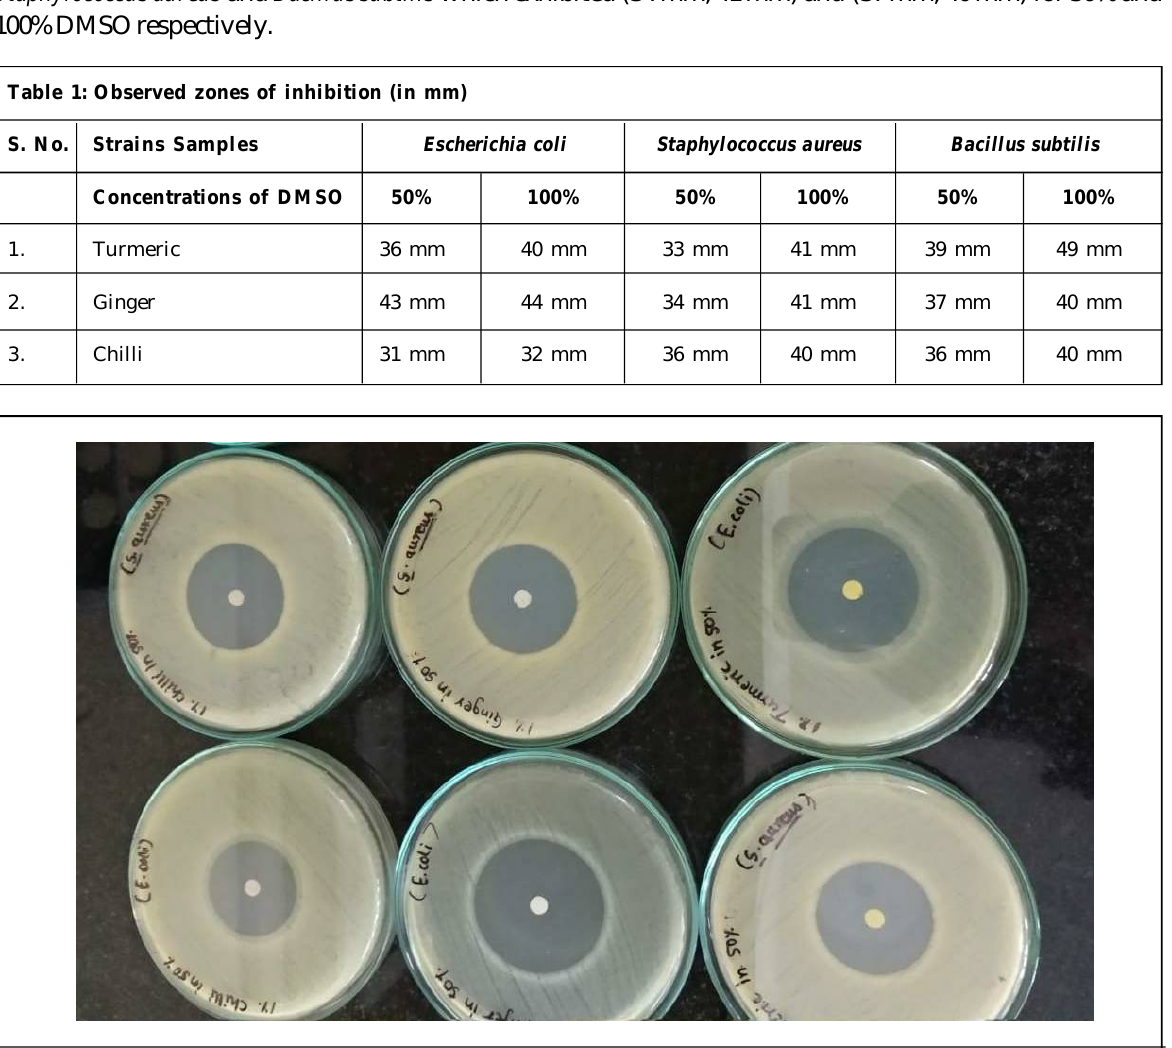
Figure 1: Zones of inhibition exhibited by 1% spice extracts prepared in 50% of